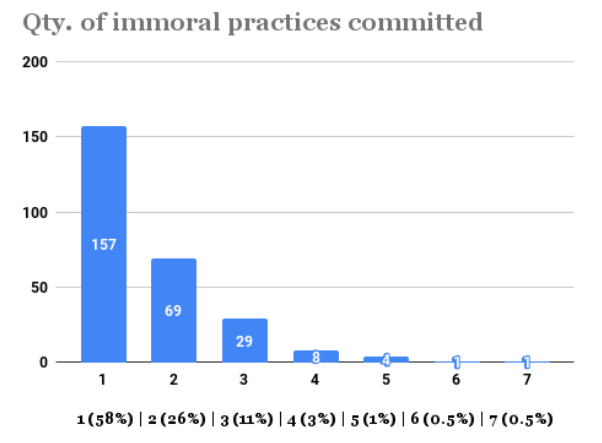
Figure 9. Qty. of immoral practices.